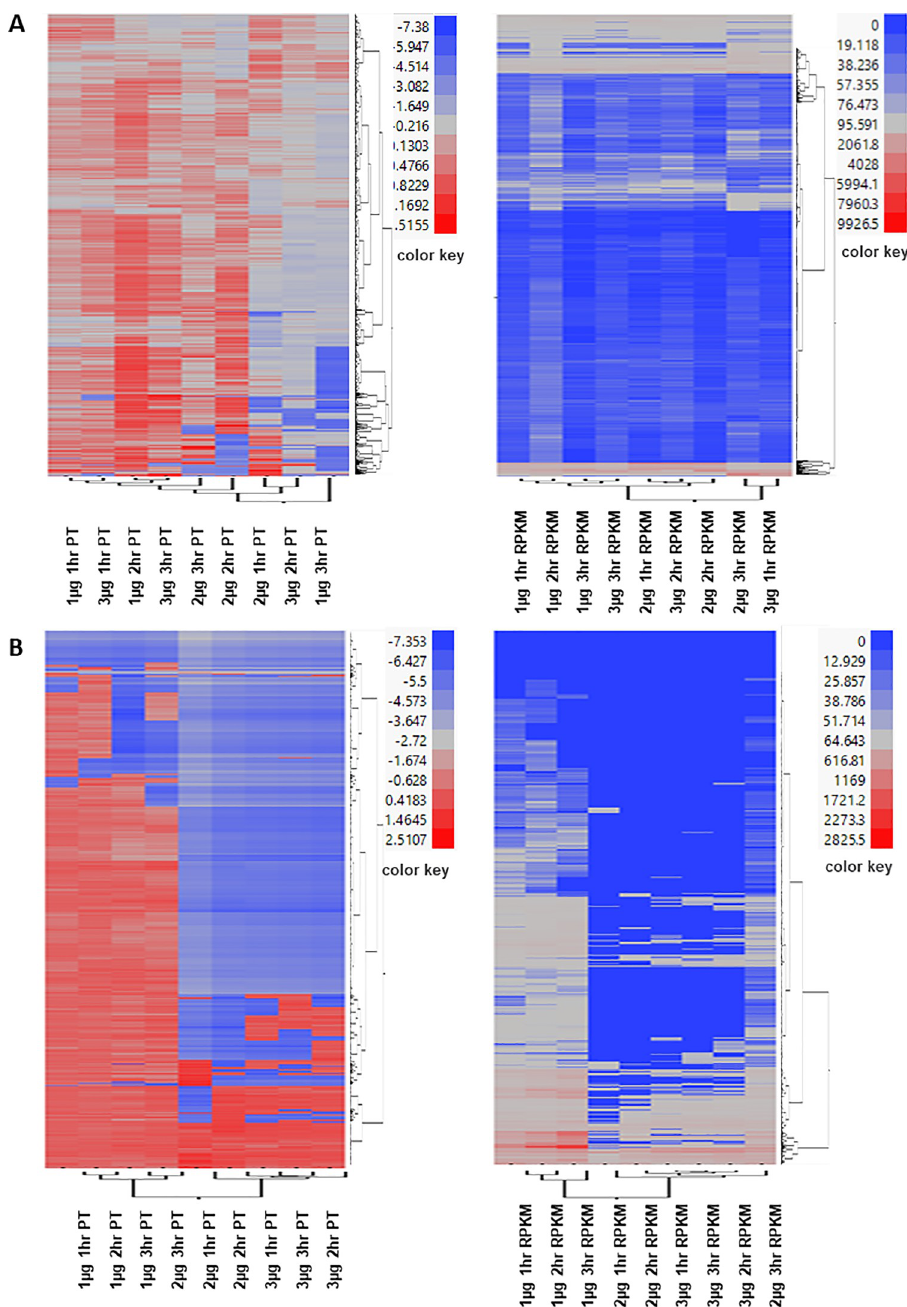
Fig 4. Two-way hierarchical clustering of differentially expressed E . coli (A) and L . monocytogenes (B) genes. Ward’s Hierarchical Clustering was performed to uncover temporal profiles based on Propensity Scores (PS) (left) and RPKM values (right) across time-points. The number of clusters was set at 20 with color-coding, as shown in detail S1 Table. Red indicates high expression and green indicates low expression. monocytogenes , including those encoding diguanylate cyclase (LMOf2365_1940, LMOf2365_1941), which were downregulated during the first hour at low dose (Fig 5B; S1 Table).